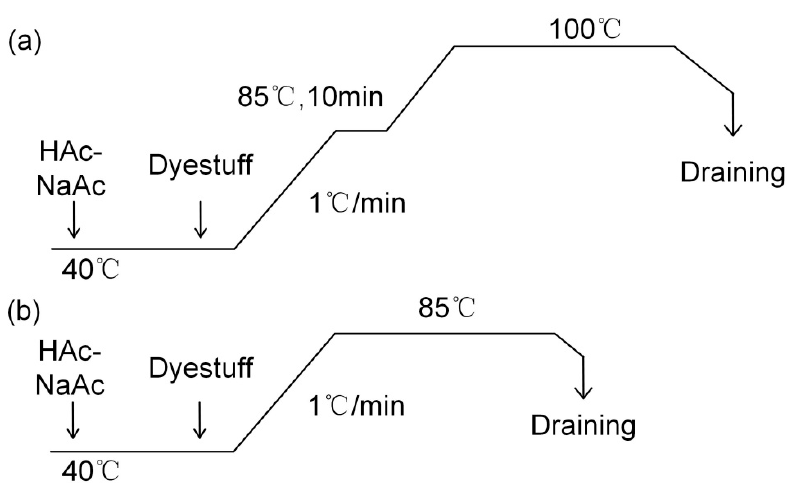
Figure 2. Dyeing curves of Lanaset Red G and Blue 2R with different temperatures: ( a ) 100 ° C; and ( b ) 85 ° C. 2.4. Reactive Dyeing